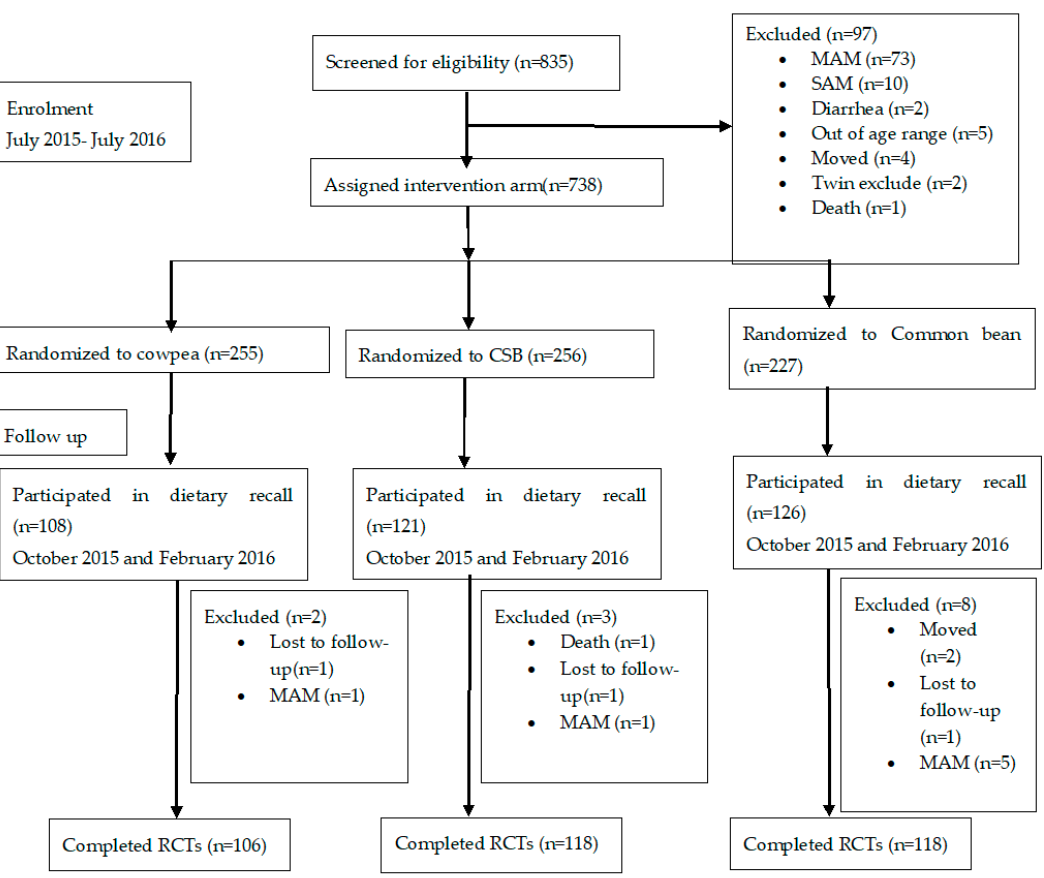
Figure 1. Flow chart of children aged 6–36 months that participated in the interactive 24-h dietary recall. MAM = moderate acute malnutrition; SAM = severe acute malnutrition; CSB = corn–soy blend; RCTs = randomized controlled trials. Table 1. Characteristics of 6 – 36 ‐ months ‐ old Malawian children who participated in 24 ‐ hour dietary recalls.